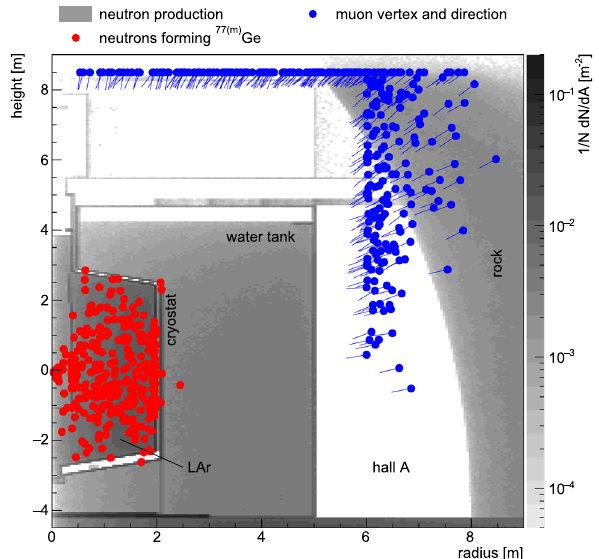
Fig. 3 Cosmic muon induced neutron production in the Gerda geom- etry. The production vertices for neutrons being captured by 76 Ge and the corresponding muons are